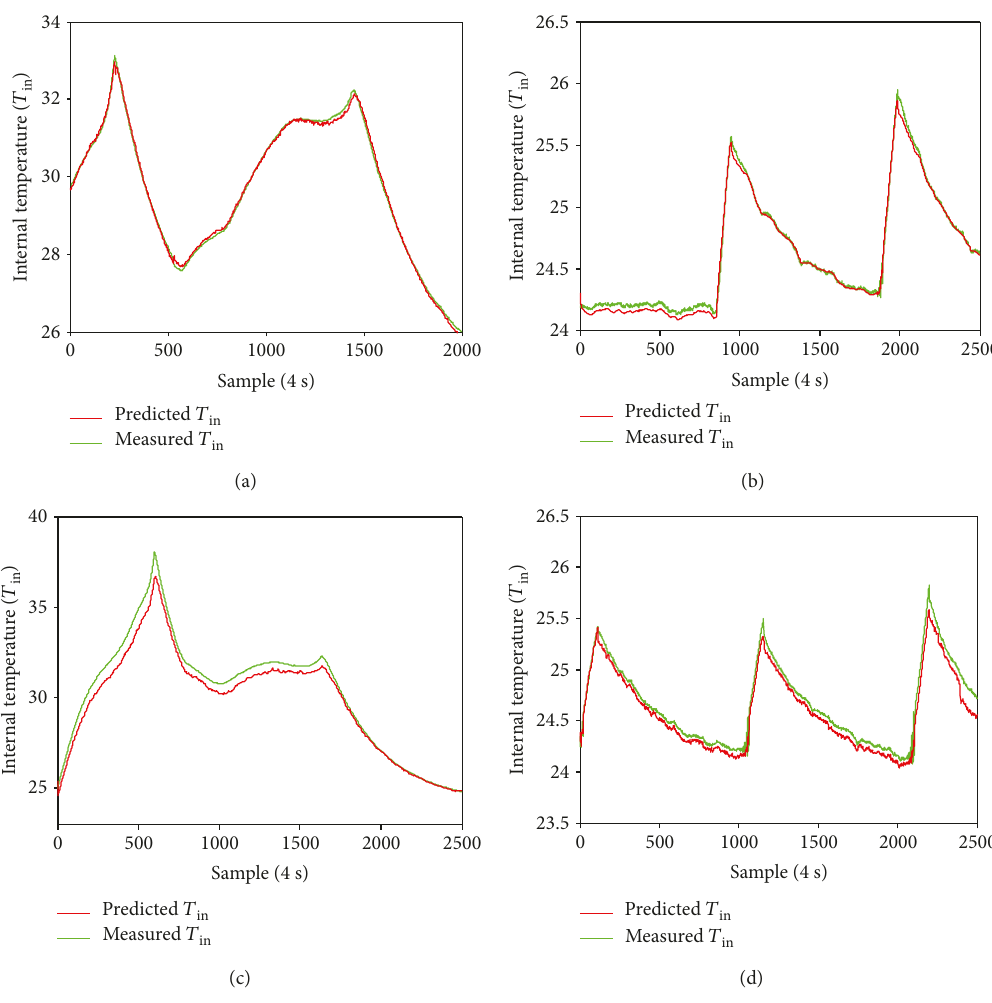
LC − T SC − T LD − T SD − T in ; (b) in ; (c) in ; (d) in .